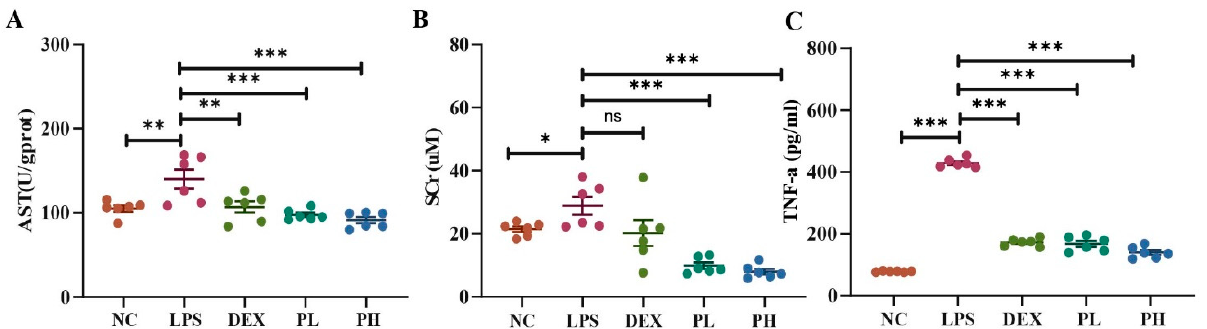
Figure 8. Pectolinarin attenuates LPS-induced liver and kidney metabolic stress. Pectolinarin treatment can significantly decrease the level of liver AST ( A ), serum creatinine ( B ) and serum TNF- α ( C ) compared with the LPS-challenged mice. Data are shown as mean ± SD (n = 6~8), * p < 0.05, ** p < 0.01, *** p < 0.001 compared with the LPS group. NC, normal control group; LPS, lipopolysaccharides-challenged (5 mg/kg) group; DEX, lipopolysaccharides-challenged and dexamethasone (10 mg/kg)-treated group; PL, lipopolysaccharides-challenged and low dose of pectolinarin (25 mg/kg)-treated group; PH, lipopolysaccharides-challenged and high dose of pectolinarin (50 mg/kg)-treated group. ns: not significant.